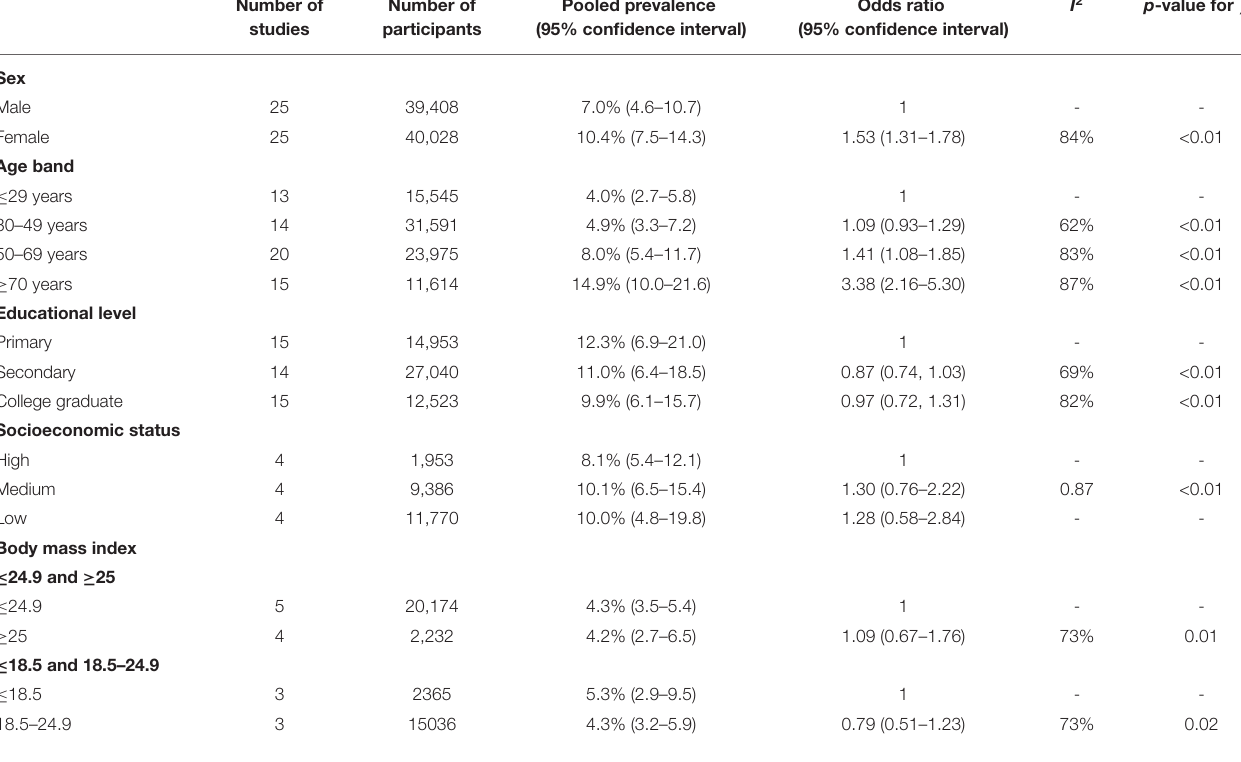
TABLE 3 | Pooled prevalence of functional constipation according to sex, age band, educational level, socioeconomic status, and body mass index